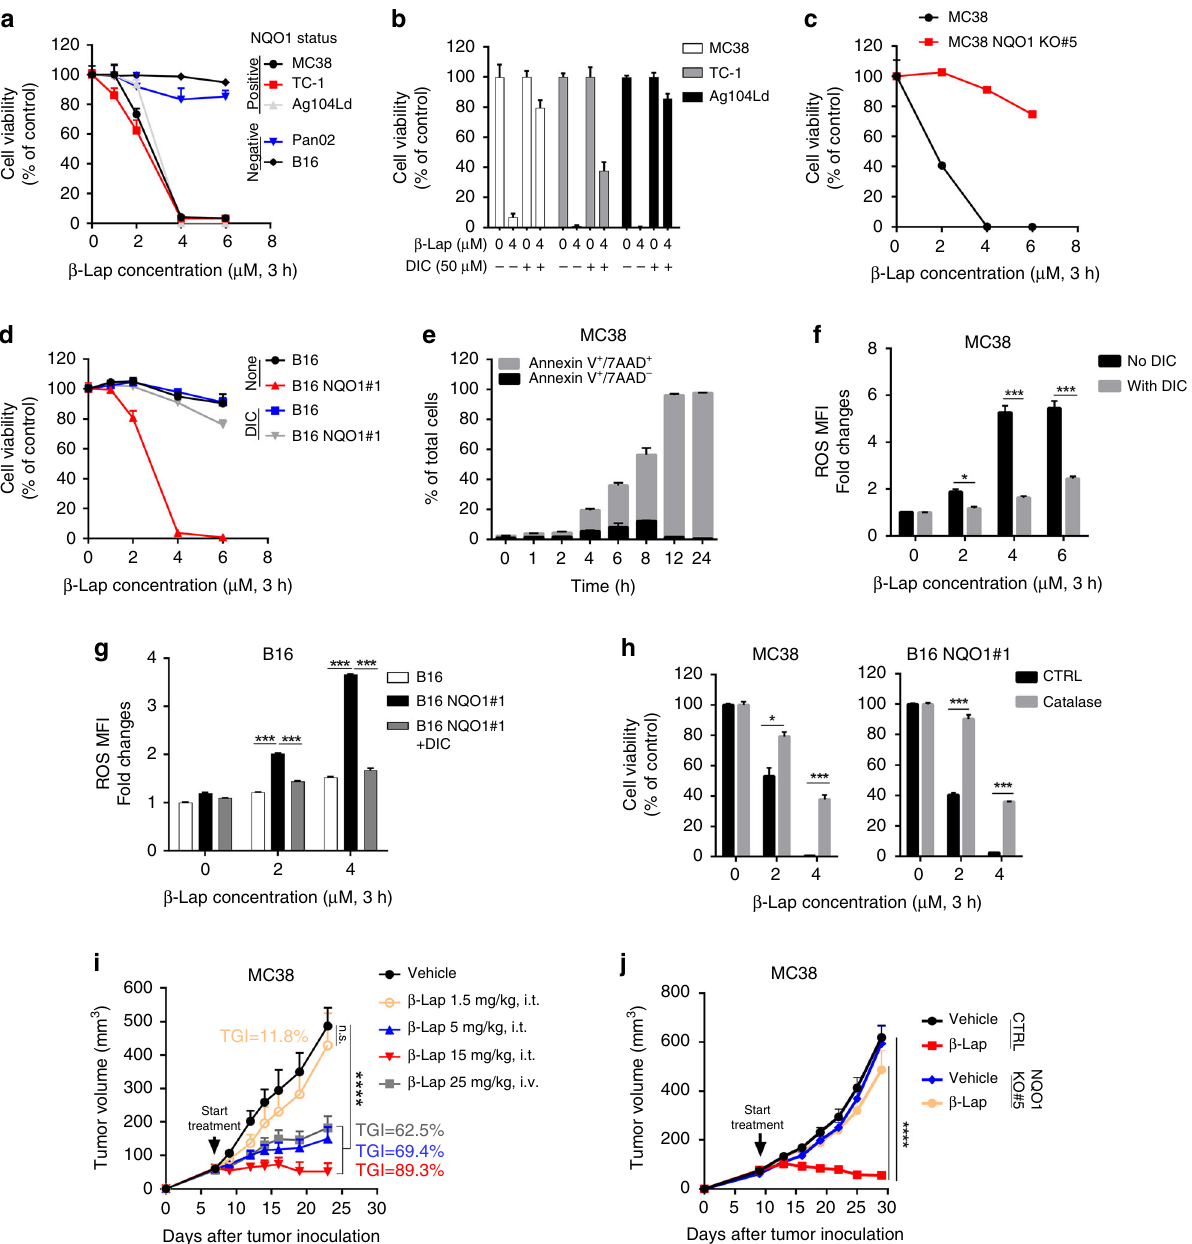
Fig. 1 β -Lap kills murine tumor cells in an NQO1-dependent manner. a NQO1 positive tumor cell lines MC38, TC-1, and Ag104Ld and NQO1 negative cell lines Panc02 and B16 grown in 96-well plates were treated with β -lap (0 – 6 μ M) for a 3 h followed by washing and replacing medium. Cell viability was determined by Sulforhodamine B (SRB) Assay 48 h later. b MC38, TC-1 and Ag104Ld cells were exposed to 4 μ M β -lap ± dicoumarol (DIC, 50 μ M) for 3 h and cell survival was assessed 48 h later. c MC38 cells with CRISPR-based NQO1 knockout (MC38 NQO1KO #5) planted in 96-well plates were exposed to β -lap for 3 h and cell survival was assessed 48 h later. d B16 cells stalely harboring a pCMV-NQO1 expression vector (B16 NQO1#1) planted in